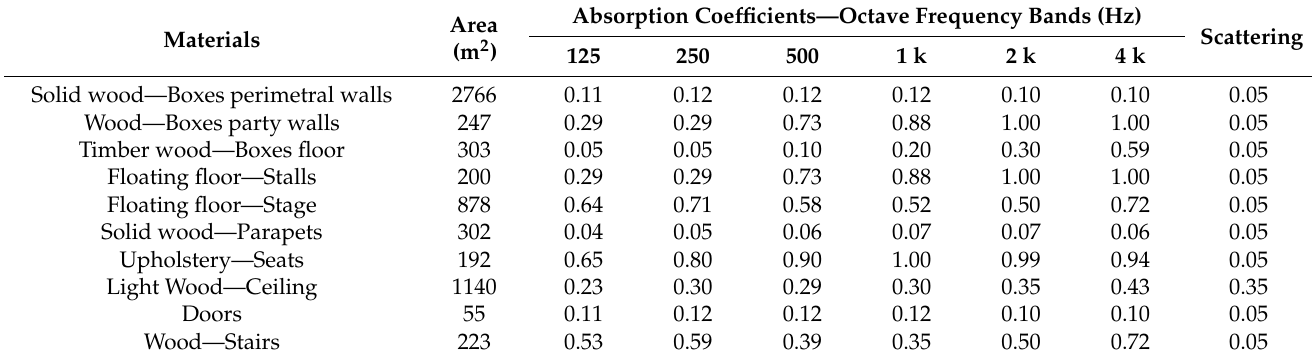
Figure 6. Digital model of the National Theater of Zagreb: perspectival view of the main hall. Table 1 indicates the absorption and scattering coefficients for all the materials con- sidered in the digital model, considered to be the result of both calibration process and extensive experience on acoustic simulations carried out for other Opera houses [15]. Table 1. Surface, absorption and scattering coefficients of the materials considered in the model of the National Theater of